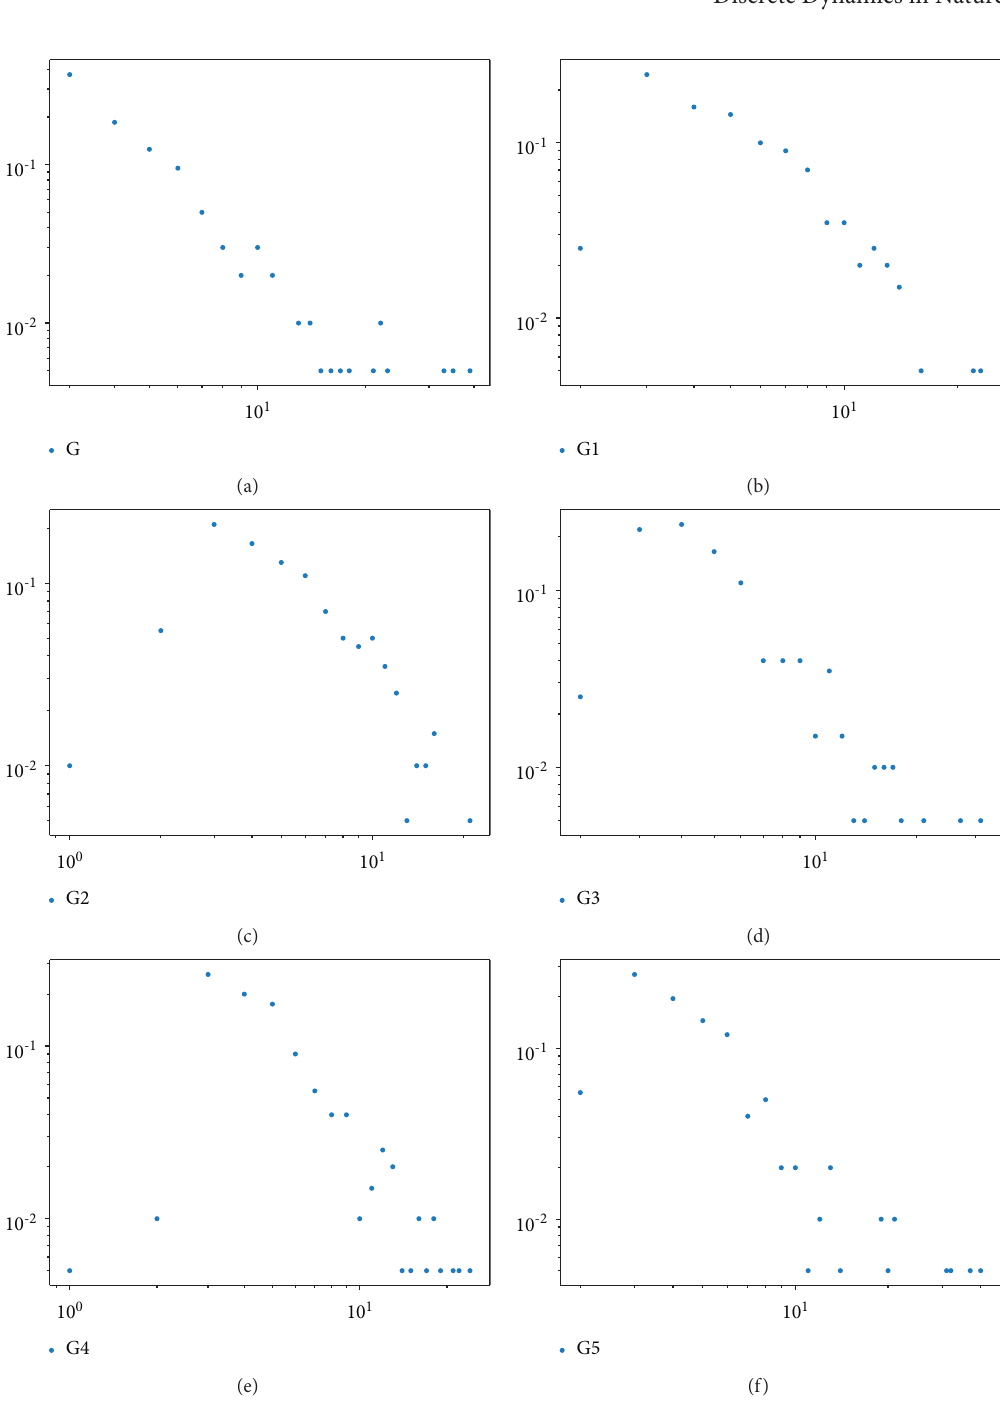
Figure 1: Comparison of the degree distribution between Model A and BA, in which G represents the BA network and G1–G5 represent the comparison of different thresholds of Model A